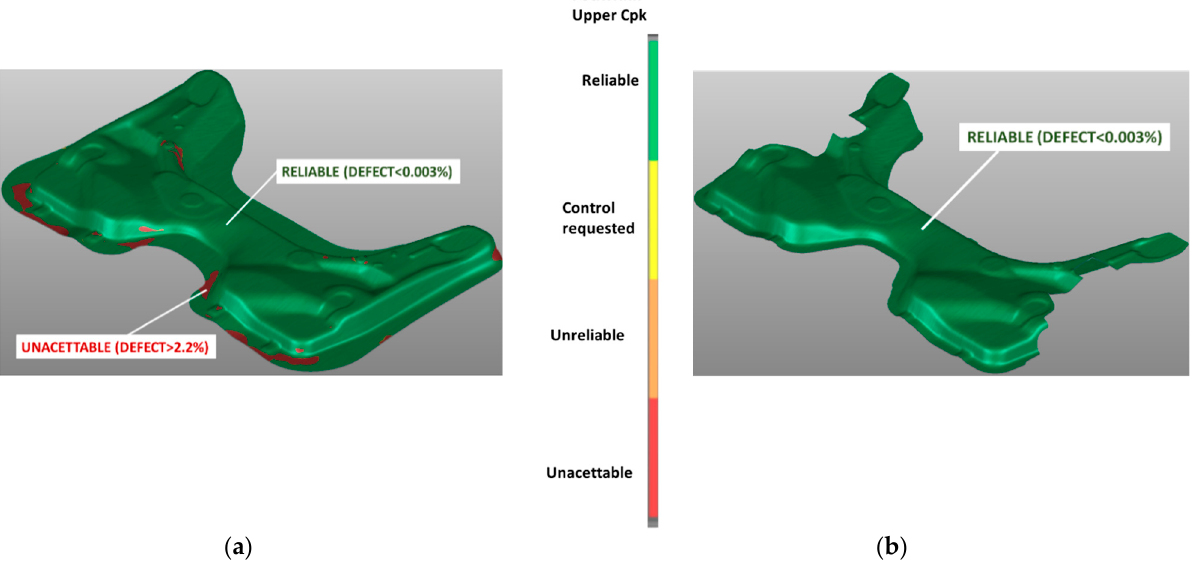
Figure 8. ( a ) Upper cp k for potential wrinkles after drawing phase; and ( b ) upper cp k for potential wrinkles at the end of the process.